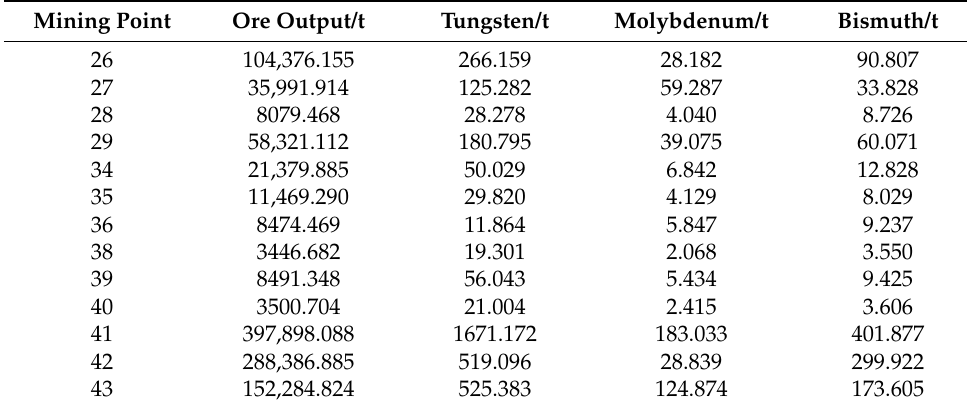
Table 5. The optimization results of the Dongbo beneficiation